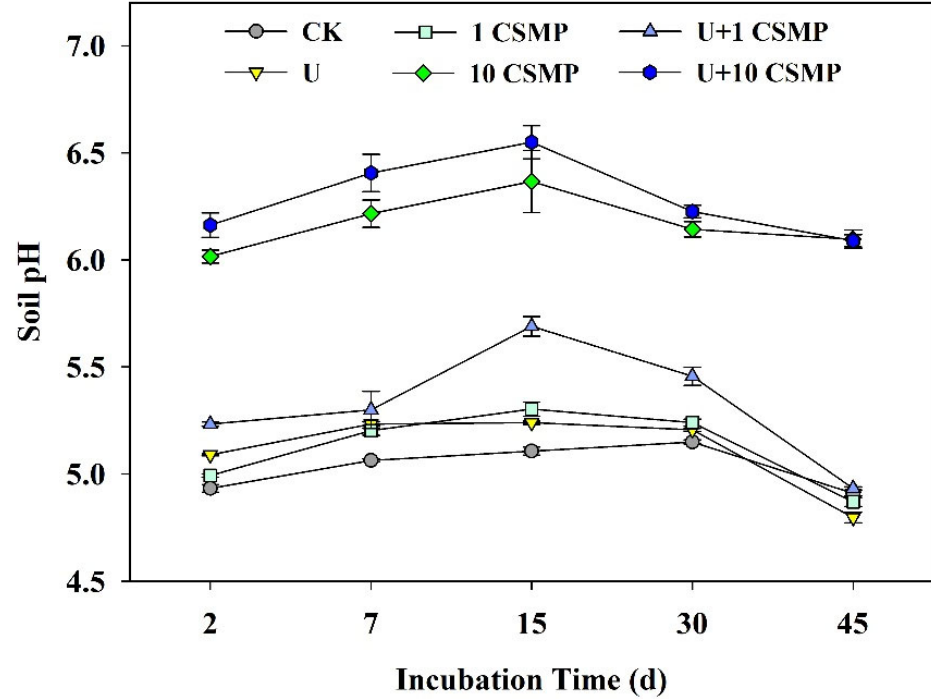
Figure 1. Soil pH as affected by the amendment during the incubation. CK, no mineral amendments or urea; U, urea at 60 mg N kg − 1 soil; 1 CSMP, 1 g CSMP kg − 1 soil; U+1 CSMP, urea at 60 mg N kg − 1 + 1 g CSMP kg − 1 soil; 10 CSMP, 10 g CSMP kg − 1 soil; U+10 CSMP, 60 mg N kg − 1 + 10 g CSMP kg − 1 soil. Error bars represent standard error of the mean (n = 3).